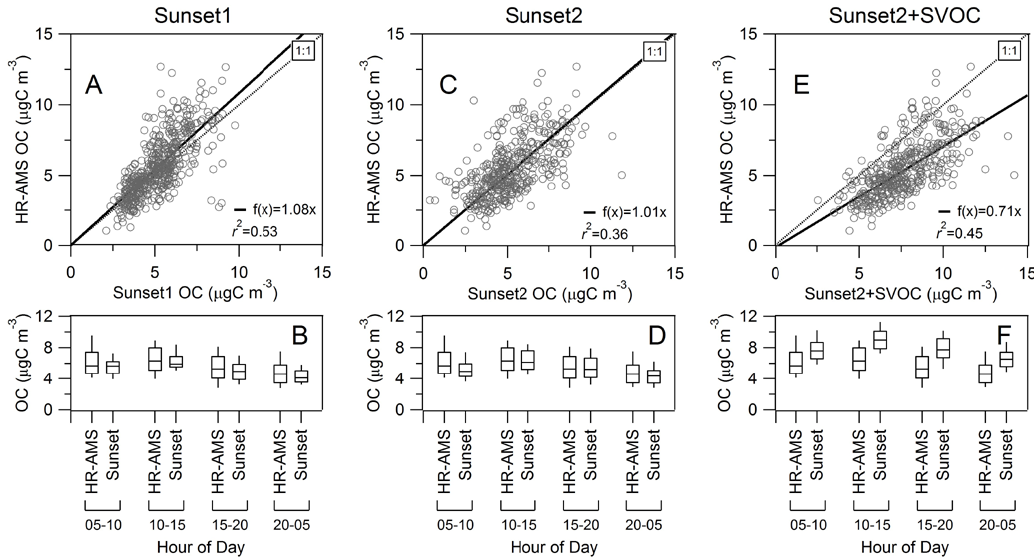
Fig. 4. Comparison of HR-AMS and Sunset OC concentrations. HR-AMS OC concentrations are plotted against Sunset1, Sunset2, and Sunset2+SVOC along with results of linear regression and correlation values in panels A, C, and E, respectively. EA results (i.e., the diurnal profile of OM/OC) were used to convert HR-AMS OM to OC to allow these comparisons. Box and whisker plots located below each scatter plot compare the various percentiles of HR-AMS and Sunset OC throughout SOAR-1 for different time periods (05:00–10:00, 10:00–15:00, 15:00–20:00, and 20:00–05:00). Boxes correspond to 25th and 75th percentiles while whiskers correspond to 10th and 90th percentiles.